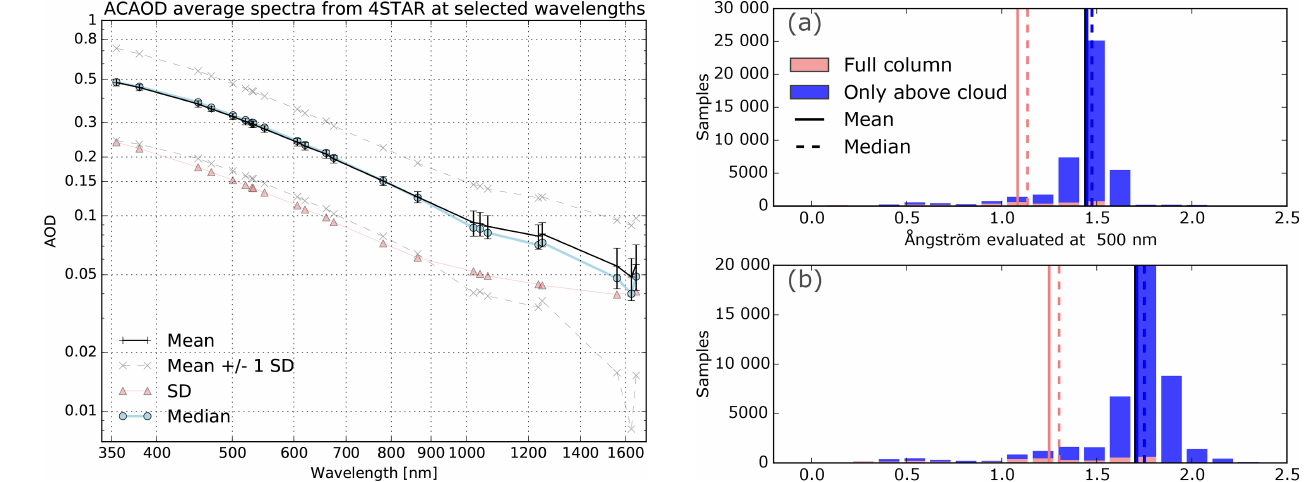
Figure 7. Histograms of Ångström exponent (AE) calculated from (a) a polynomial fit of AOD sampled by 4STAR evaluated at 500nm and (b) using the two-wavelength ratio (470 and 865nm) in log– normal space, for the full-column AOD (pink) and the ACAOD